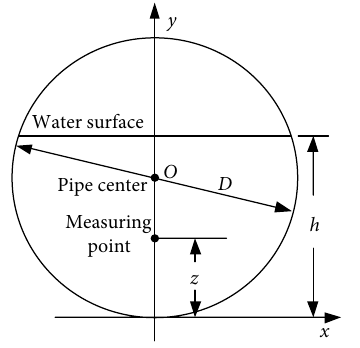
Figure 1: Diagram of section of measuring pipe.